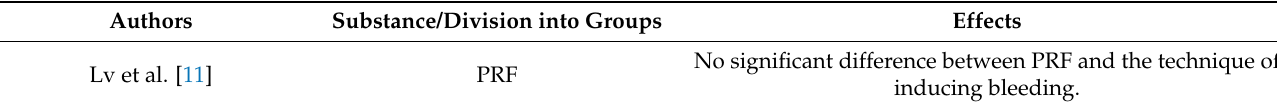
Table 1. Description of the results observed by Lv et al. [11], Narang et al. [51], Shivashankar et al. [52], Murray [53] and Sharma et al.